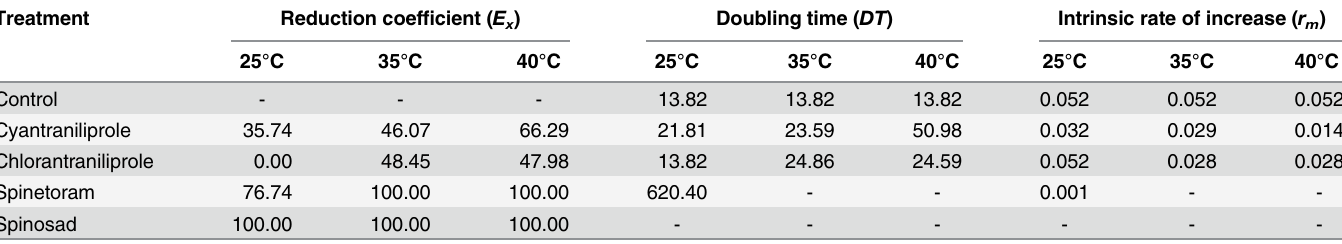
Table 3. Reduction coefficient E x [6], Doubling time ( DT ) and Intrinsic rate of increase ( r m ) [35] estimated for Bracon nigricans adults exposed to the four tested insecticides at three constant temperatures and for the control parasitoid population.